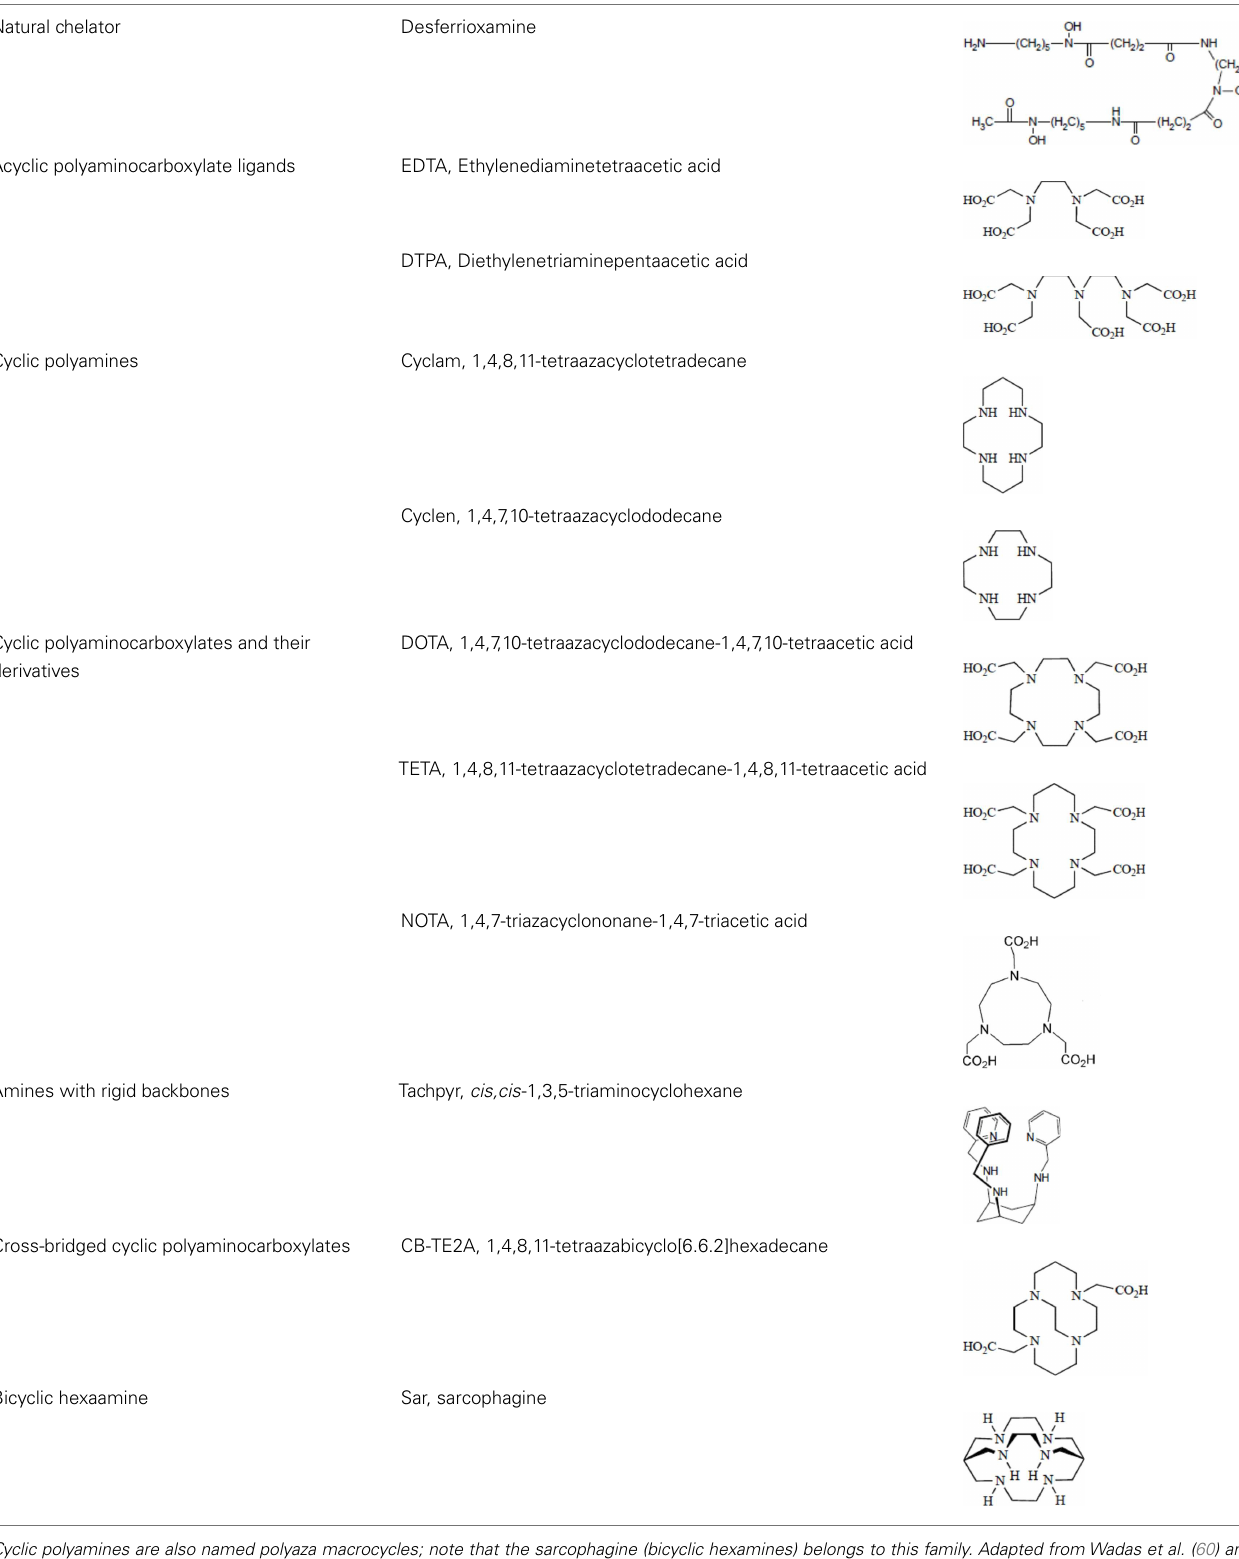
Table 1 | Chelator families and their representative for metal complexation. Natural